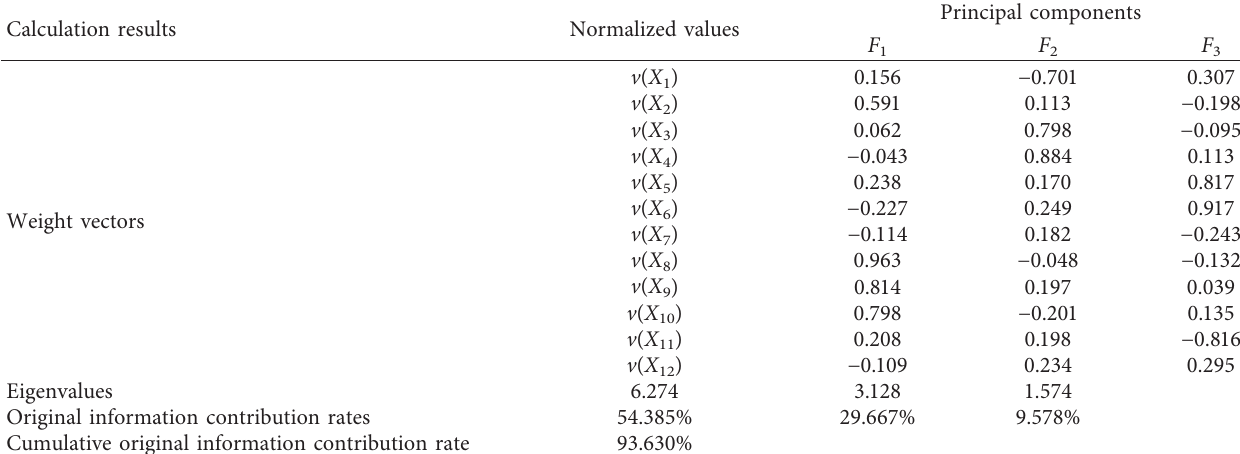
Table 4: Principal component analysis results of the structural